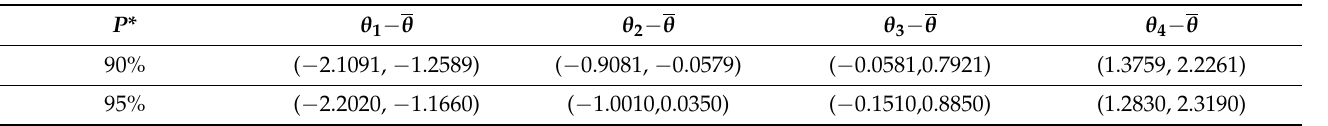
Table 1. The 90% and 95% one-sided confidence intervals and two-sided confidence interval for four drugs compared with average.